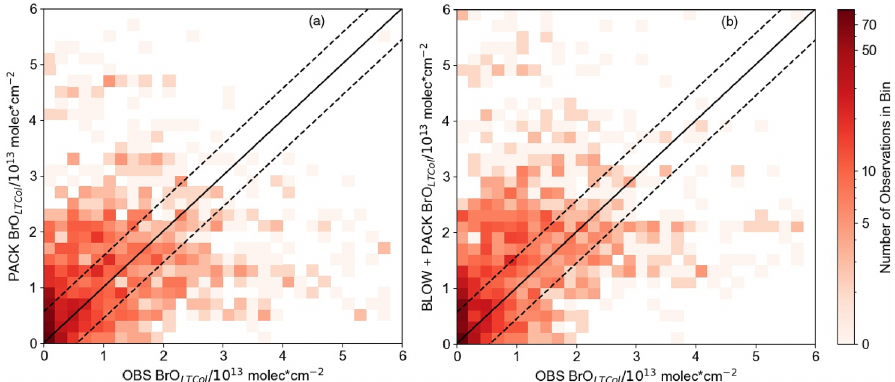
Figure 7. Hourly modeled BrO LTcol versus BrO LTcol observations. Two-dimensional histograms showing the density of GEOS-Chem- predicted BrO LTcol versus all observed spring 2015 hourly Br LTcol , with (a) PACK BrO LTcol shown on the left sorted into square bins of 0.2 with a Pearson r correlation with observations of 0.33 and (b) BLOW + PACK BrO LTcol on the bottom sorted into square bins of 0.2 with a Pearson r correlation with observations to 0.39. All units are in moleculescm − 2 . 1 : 1 line drawn in the center in black, with a margin of the average observational error plotted in dashed black lines around the central 1 : 1